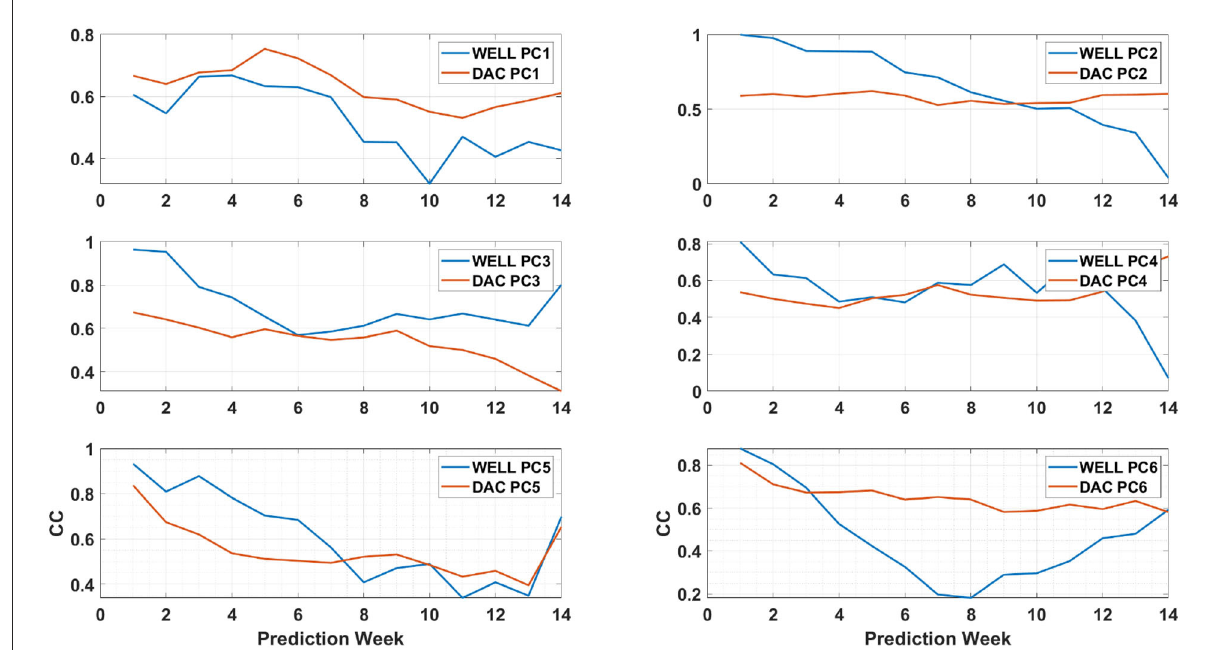
FIGURE12 The first six principal components (PCs) linear correlation coefficient (CC) time evolution over a 14-week prediction period of formation of eddy Cameron. The blue (red) solid line shows the WELL (DAC) model PC CCs. For the DAC model, each PC was averaged across all six partitions. The linear correlation coefficients were calculated with HYCOM PCs for the same